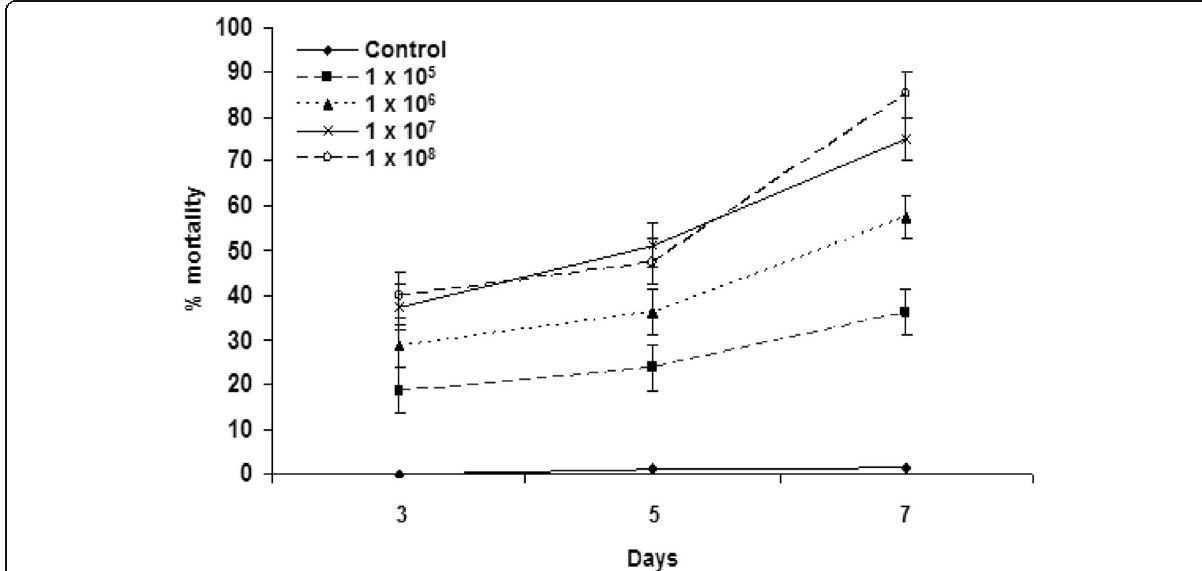
Fig. 1 Lethal effect of Metarhizium anisopliae isolate to Tetranychus urticae after treatment with conidial suspensions at concentration 1 × 10 5 , 1 ×